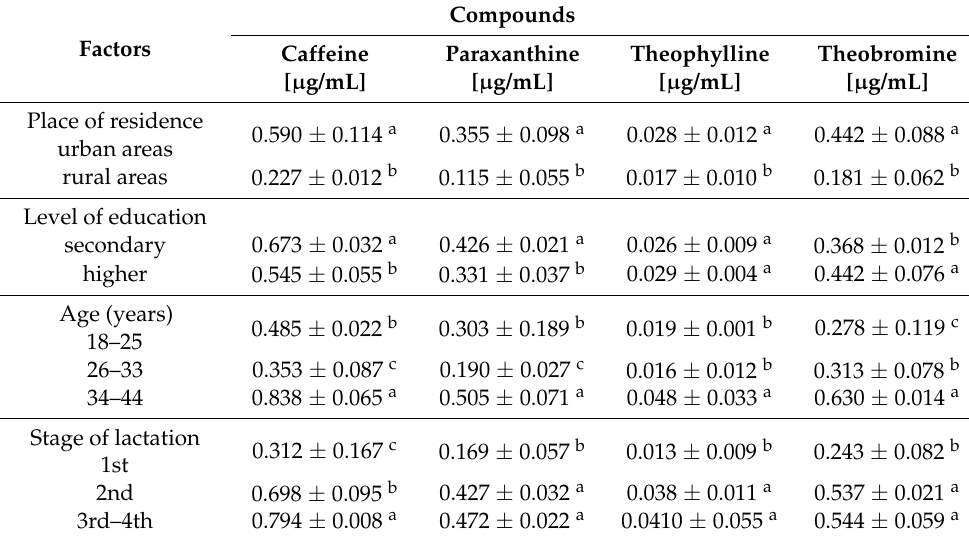
Table 4. The content of caffeine, paraxanthine, theophylline, and theobromine in breast milk according to selected